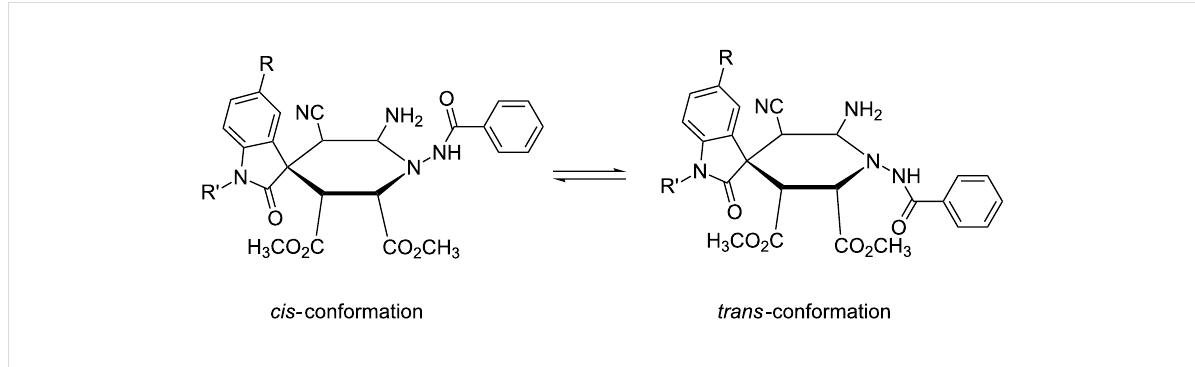
Scheme 1: The dynamic equilibrium of cis/trans -conformation of spiro[indoline-3,4'-pyridine].